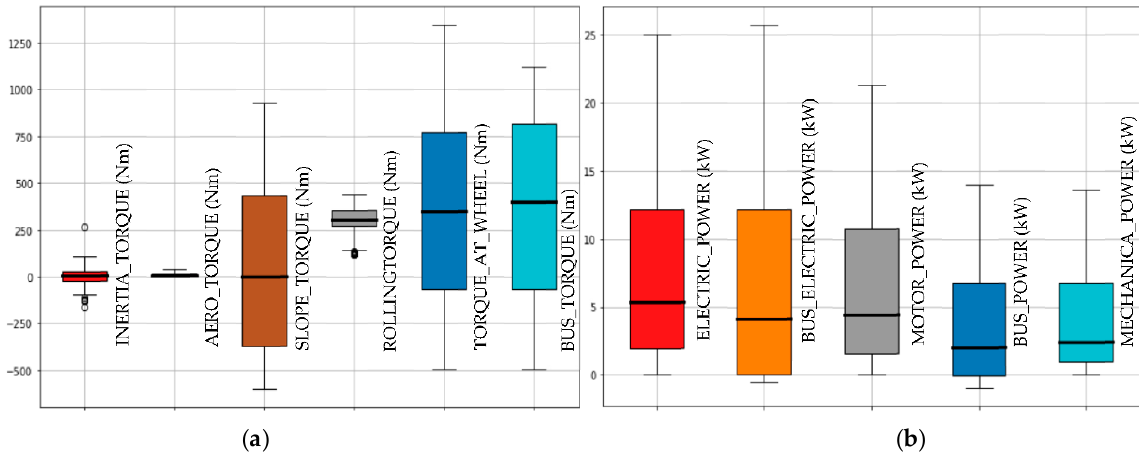
Figure 17. ( a ) Torque boxplot; ( b ) Power